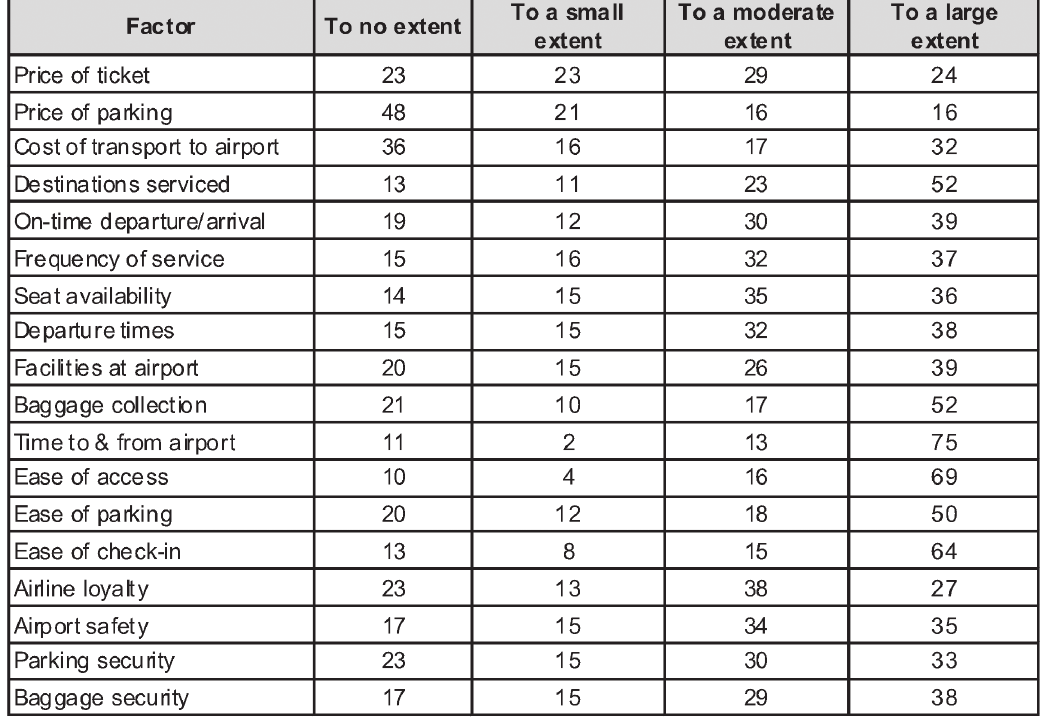
Table 5: Frequency analysis of determining